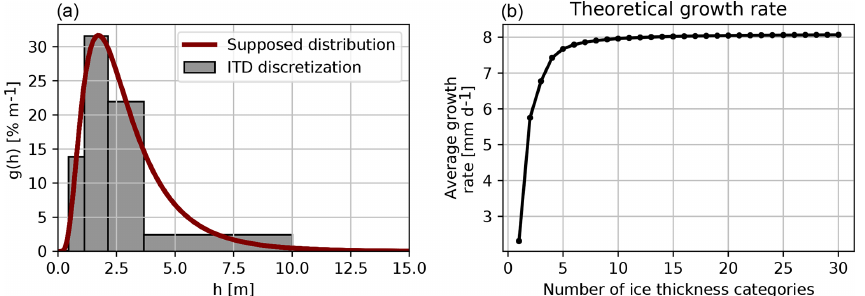
Figure 6. (a) A supposed ice thickness distribution in a model grid cell (red; log-normal distribution with mean 3m and standard deviation 2m) and its discretization in five categories following the default formulation of LIM3 (grey bars). (b) Average basal growth rates for 1 , 2 ,... 30 categories. For each category, the basal growth rate was computed assuming sea ice thickness equal to the category mean ( h i with i = 1 ,...,N , where N is the number of categories), assuming no snow, an atmosphere–ocean temperature difference of (cid:49)T = 30K, sea ice conductivity of k = 2WmK − 1 , latent heat of fusion of L f = 334000Jkg − 1 and sea ice density of ρ i = 917kgm − 3 . The growth rates